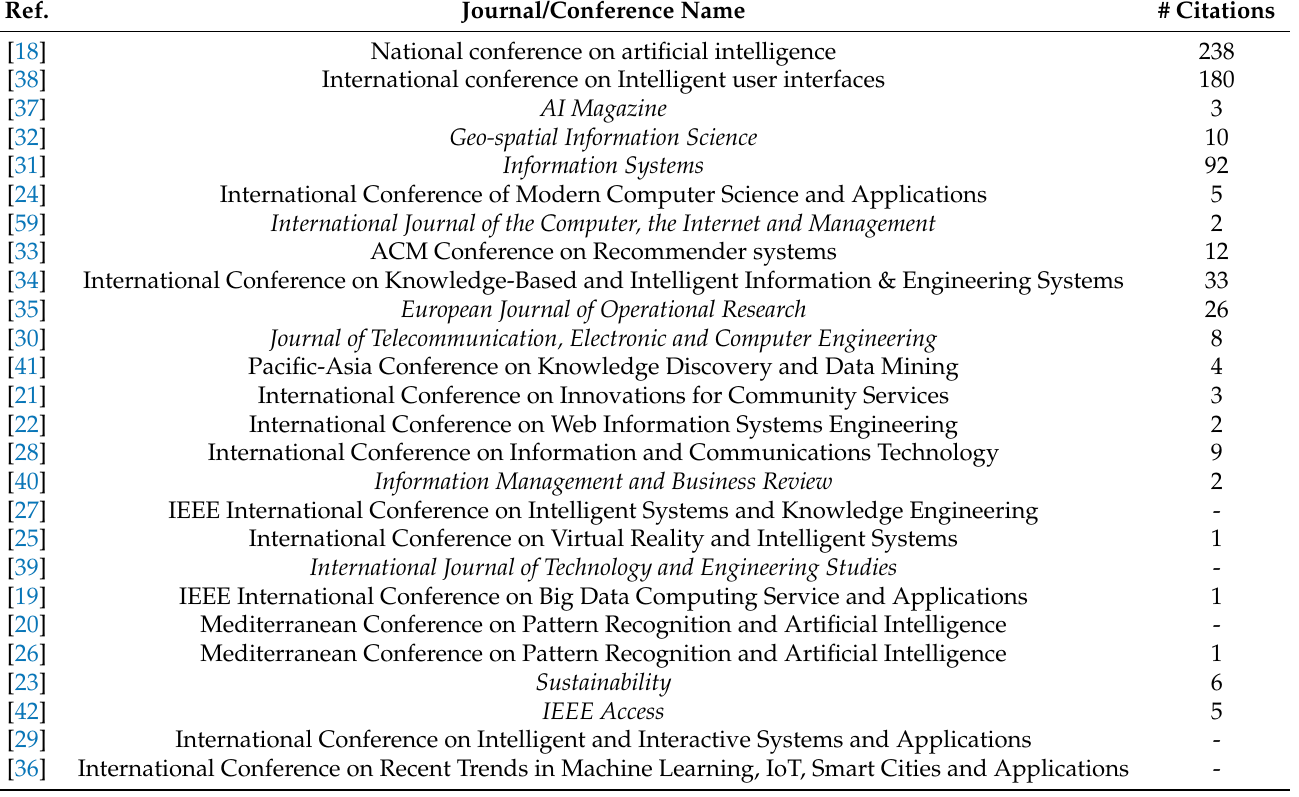
Table A2. Summary of the selected papers with their journal/conference names and number of citations.